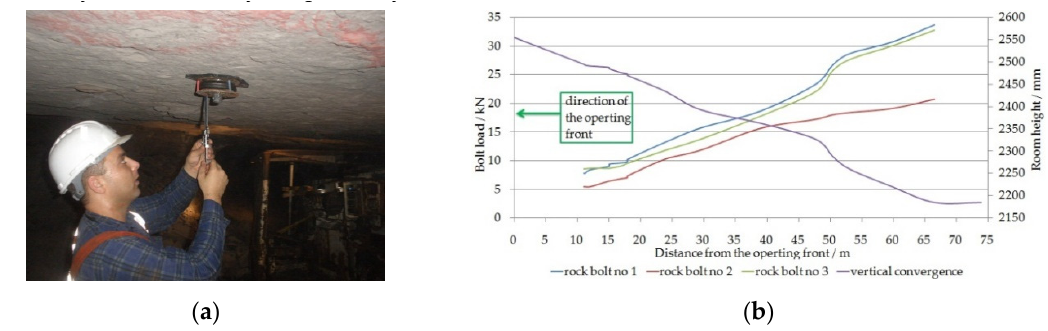
Figure 6. In situ tests of rock bolt support in a stratified rock mass: ( a ) indirect bolt load measurement; ( b ) increase of bolt load and room convergence in reference to the distance from the operating front.